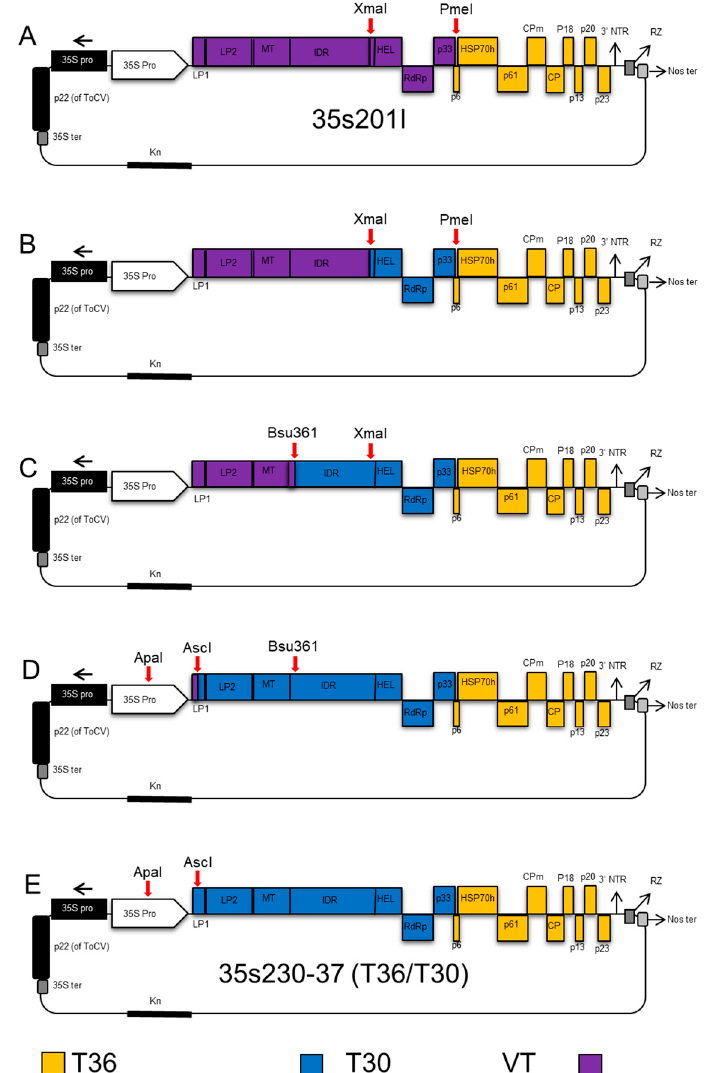
Figure 1. Schematic representation describing the cloning steps of the Citrus tristeza virus (CTV) T30-T36 (35s230-37) infectious hybrid clone. ( A ) The 35s201I plasmid vector of VT-T36 was used as a backbone clone; ( B ) the fragment containing the helicase, RdRP , and p33 was amplified from strain T30, and ligated into plasmid vector 35s201I, which was digested with restricted enzymes XmaI and PmeI; ( C ) the fragment containing leader protease LP2 to helicase from T30 was amplified and ligated into the plasmid vector after digesting with Bsu361 and XmaI; ( D ) the fragment covering nucleotides 182 to 4431 from the T30 strain was amplified and ligated into the vector after digestion with AscI and Bsu36I restriction enzymes; ( E ) the fragment containing the AscI restriction enzyme site until the 182 nt was amplified and added to the plasmid vector digested with ApaI and AscI restriction enzymes to produce the new infectious hybrid clone named 35s230-37 used for studying the transmission of CTV.